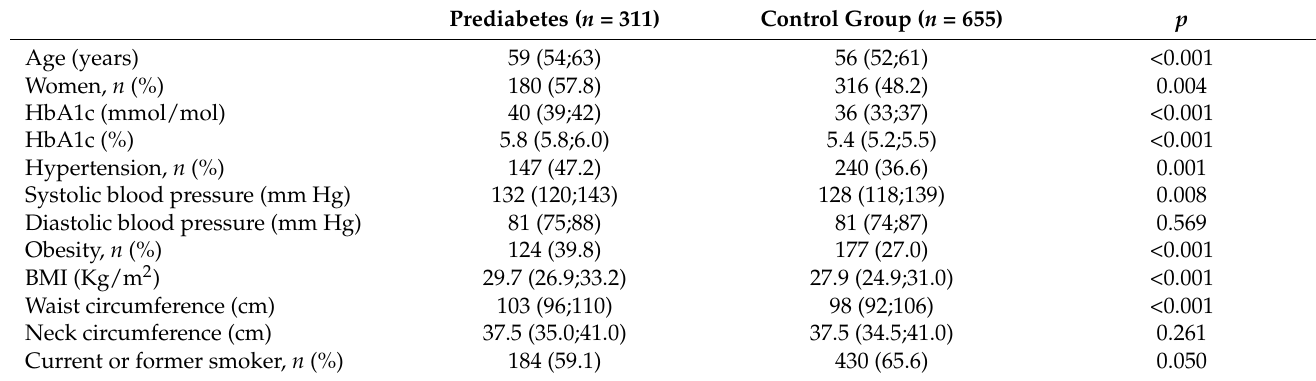
Table 1. Main clinical characteristics of the study population according to the presence of prediabetes.